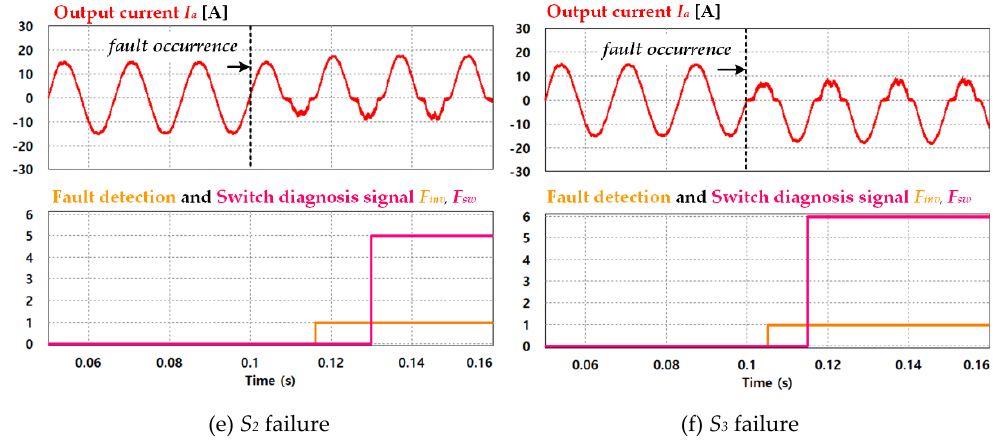
Figure 11. Simulation results of the open-switch fault detection with A-leg current waveform.